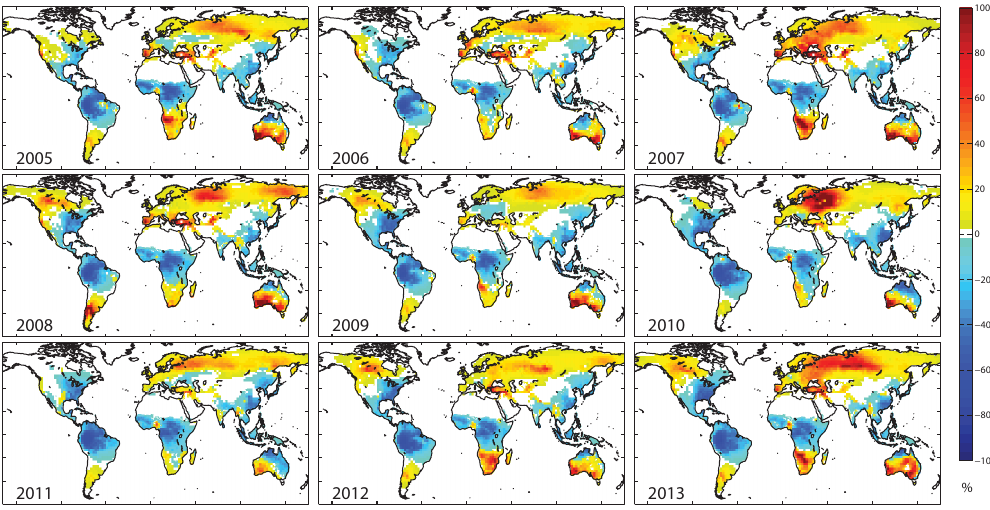
Figure 6. Updates (percentage change from the a priori) in annually averaged isoprene emissions inferred by the optimization for all years of the study